Question: Name the type of graph shown.
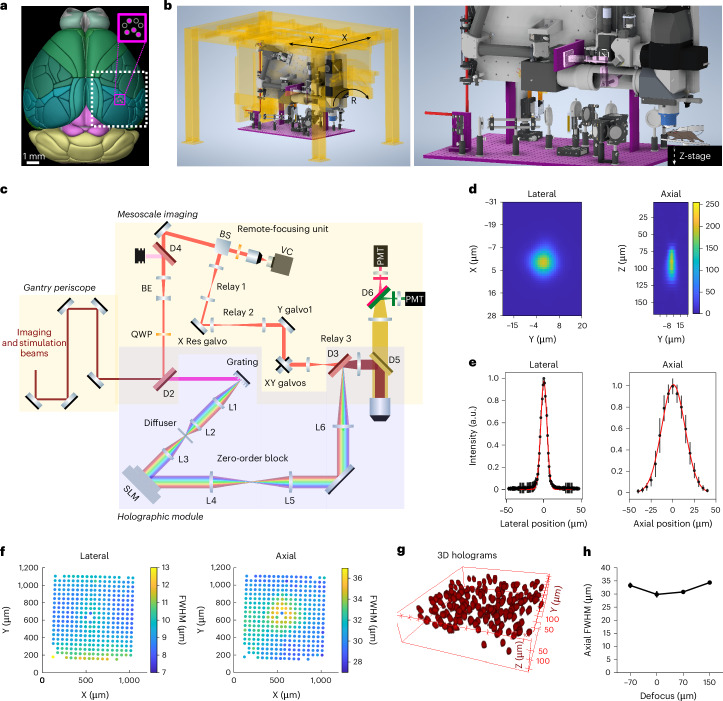
Answer: bar